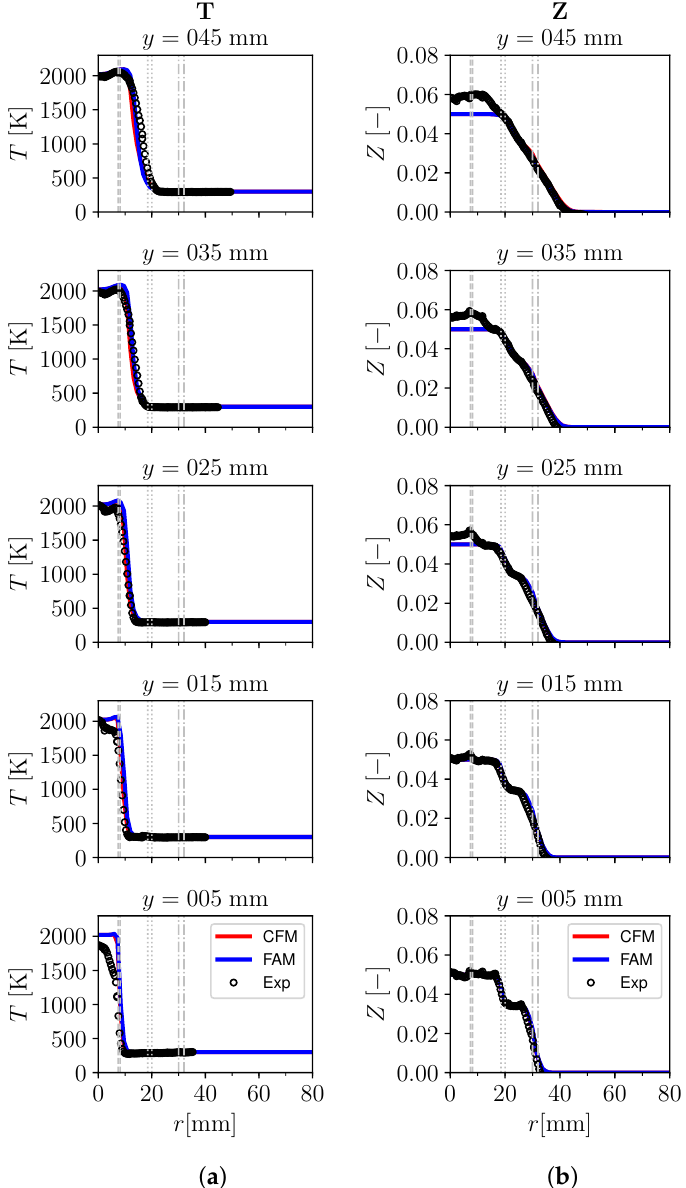
Figure 9. Case A-r: radial profiles of mean temperature T ( a ); and mean mixture fraction Z ( b ); computed with different models at axial positions 5 mm